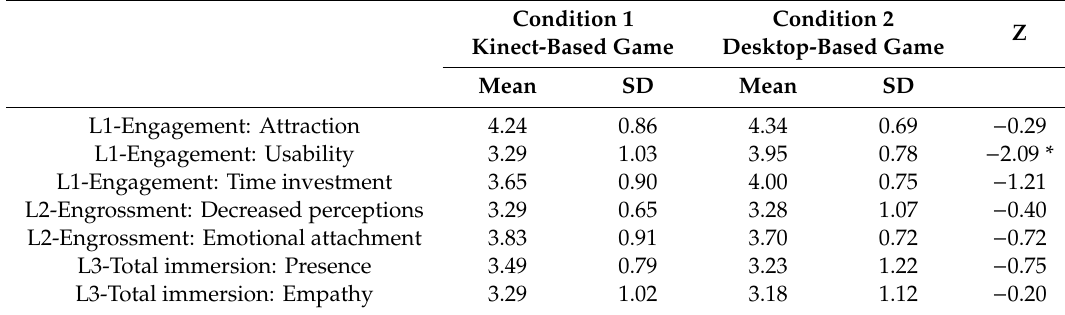
Table 4. Pre-test scores, post-test scores, and normalized learning gains per